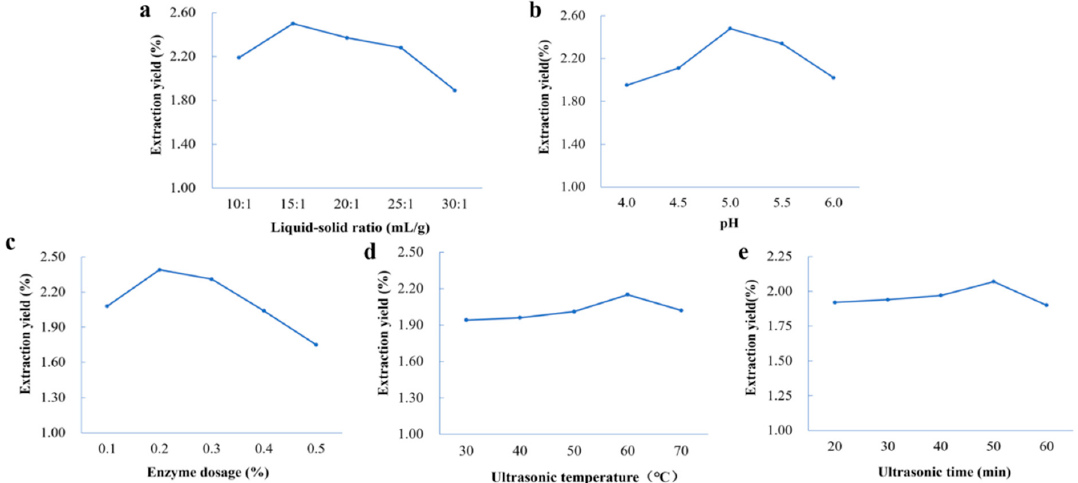
Figure 2. Single-factor effects on the extraction yield of total coumarins: ( a ) liquid–solid ratio, ( b ) pH, ( c ) enzyme dosage, ( d ) ultrasonic temperature and ( e ) ultrasonic time.